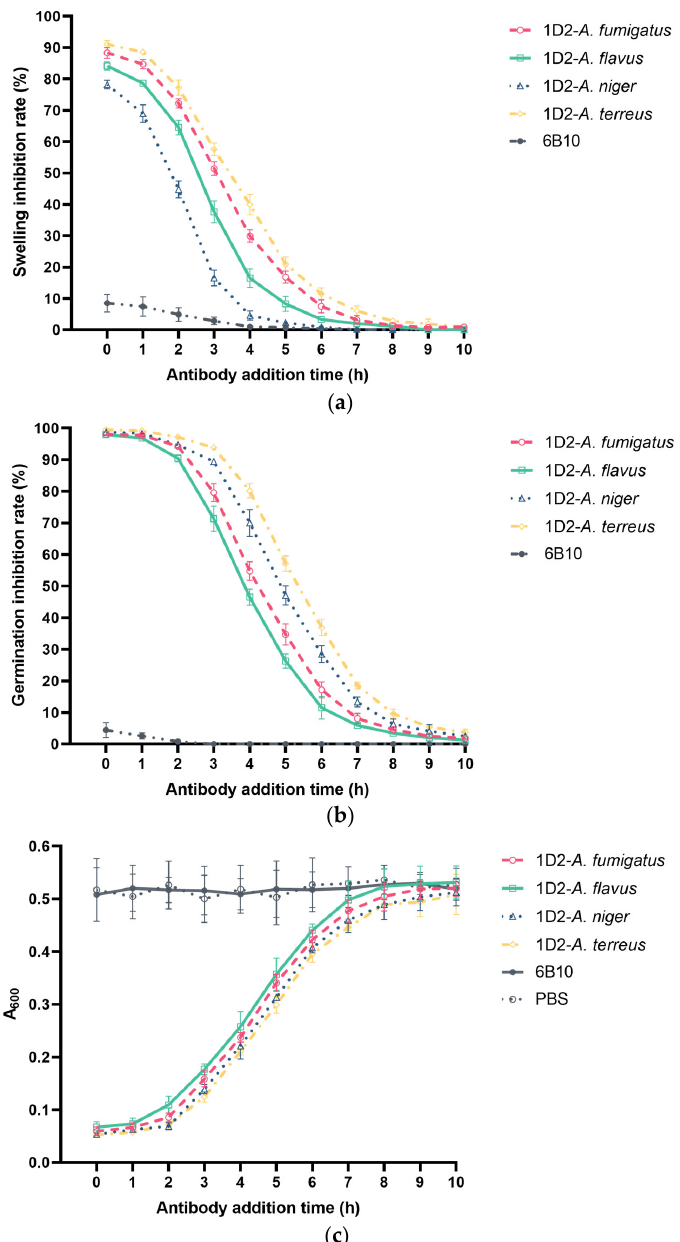
Figure 6. Effect of 1D2 (100 µg) intervention on Aspergillus conidial swelling and germination as a function of time. MAb 1D2 treatment resulted in significant inhibition of Aspergillus swelling ( a ) when added together with the conidia (0 h). The swelling inhibition ability against all Aspergillus species was downregulated markedly and reached a lower plateau after the sixth hour. In addition, mAb 1D2 showed significant inhibition capability on Aspergillus germination when it was added at the first two hours of culture ( b ), and the inhibitory ability dropped sharply between the third and seventh hour of culture. These inhibitory effects at different time points result in significantly lower absorbance ( c ) in the first two hours, which increased dramatically between the third and the seventh hour, and then finally hit stationary phase after seven hours of incubation. A 600 : absorbance at 600 nm.